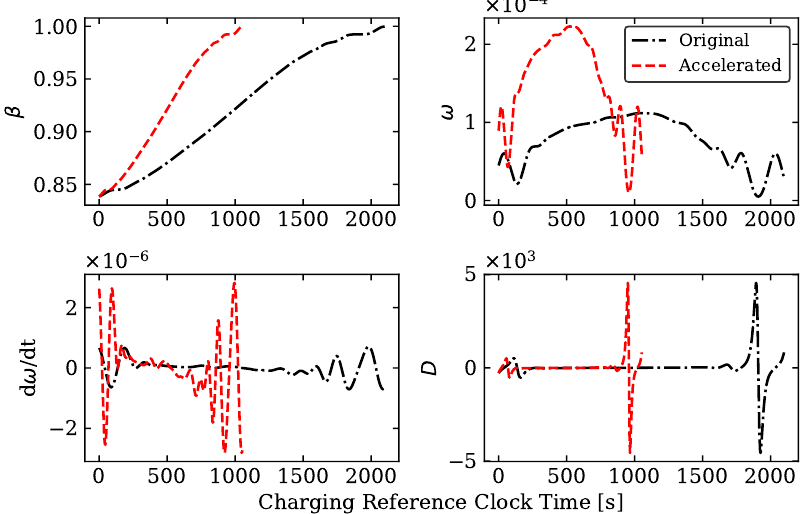
Figure 5. Scaling comparison of charging mode at the centerline, phase